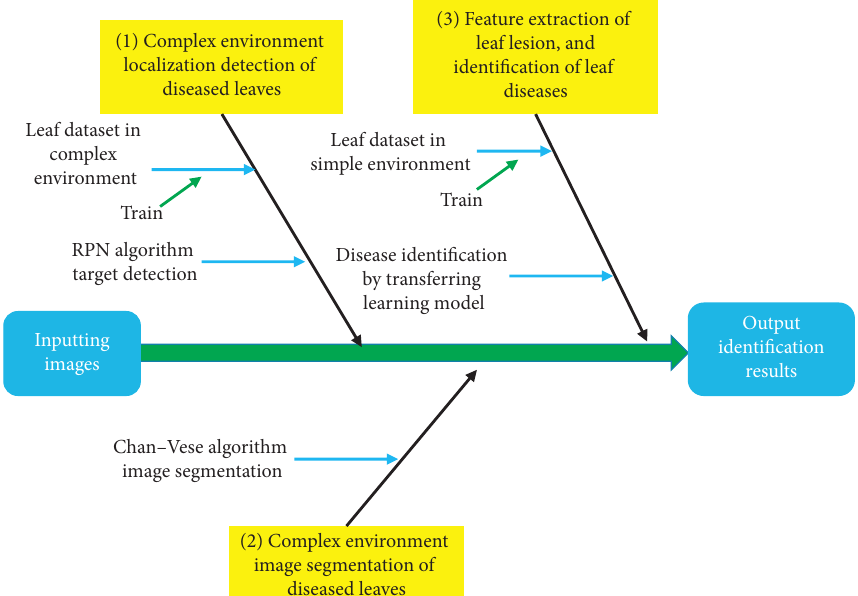
Figure 1: The identification model